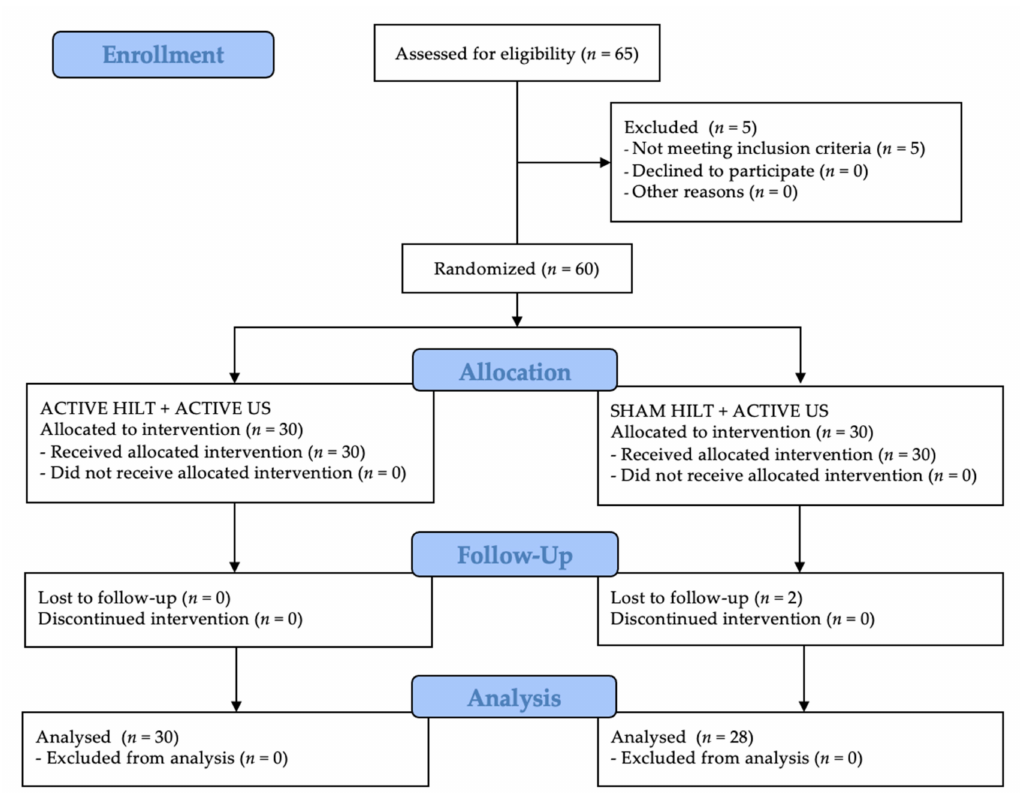
Figure 1. CONSORT flow chart of the study participants. Abbreviations: HILT, high-intensity laser therapy; US, ultrasound